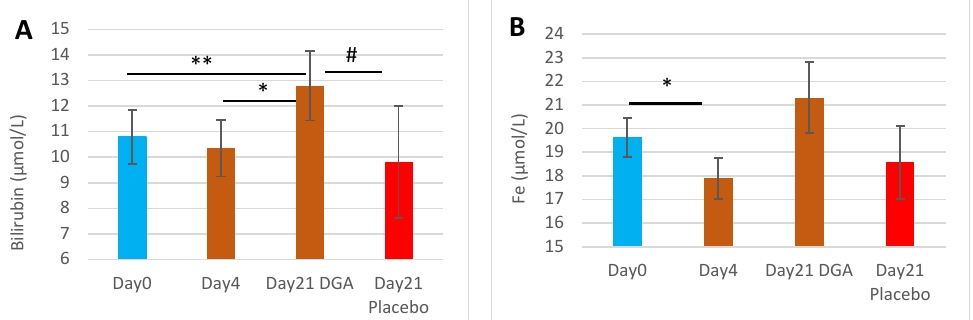
Figure 1. End products of the HO-1 pathway in blood 12 h after the last DGA or placebo dose: ( A ) Mean (±SEM) blood bilirubin concentration, ( B ) Mean (±SEM) blood Fe concentration. Notes: (1) The Day21 DGA and Placebo averages are indexed to Day0 so that Day21 fully reflects the change from Day0. (2) * and ** indicate paired t -test, # indicates non-paired t -test between the%-changes from Day0 to Day21.